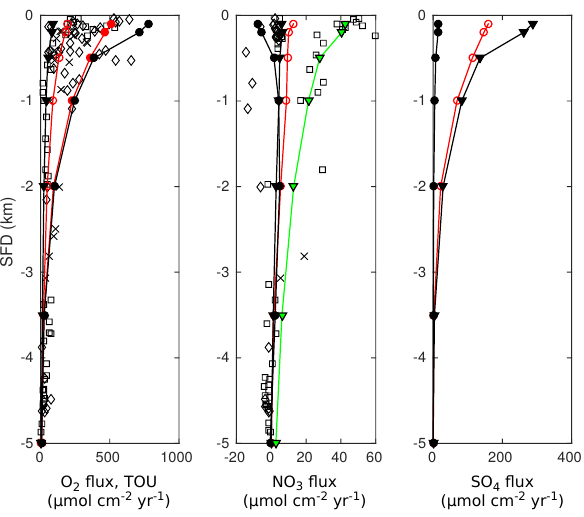
Figure 8. Fluxes of O 2 , NO 3 and SO 4 to the sediment along the global hypsometry. Red lines (with open symbols) are modelled fluxes from Thullner et al. (2009) using BRNS; black lines are = γ = 0 . 95; (cid:72) : γ NH = results from OMEN-SED ( • : γ NH H 2 S 4 4 = 0 . 05). Observations of TEA fluxes are taken from Middel- γ H 2 S burg et al. (1996) ( Also plotted in the figure (far left panel) are the total oxygen uptake (TOU) estimates of Thullner et al. (2009) (filled red symbols). The green line indicates OMEN-SED results for low oxygen and high nitrate levels and the lower NC ratio. Positive fluxes are directed from the ocean into the